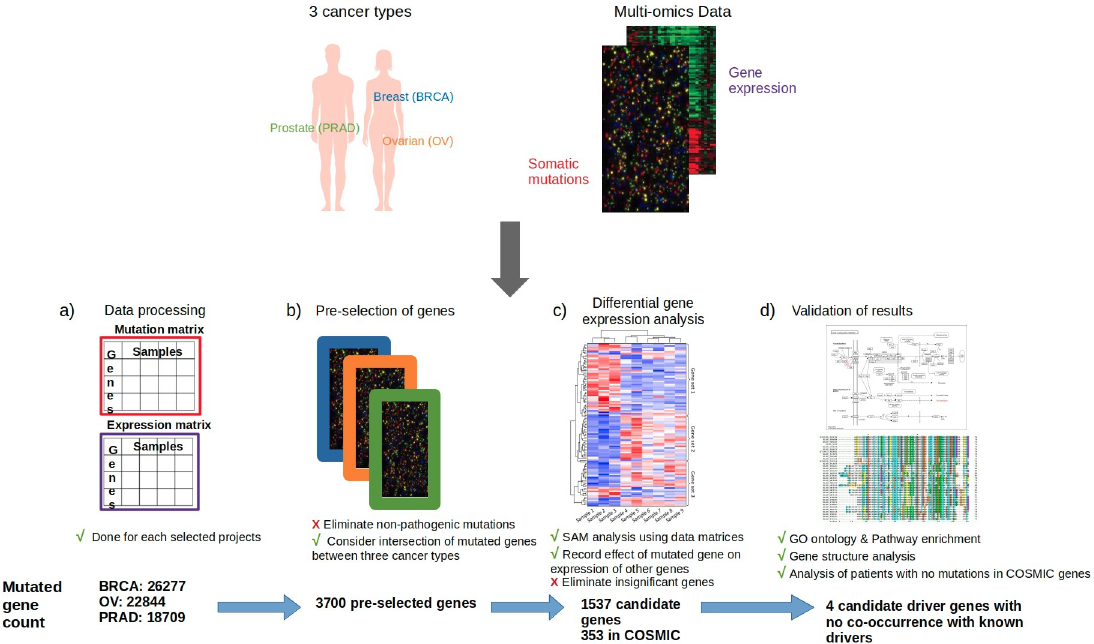
Fig 1. Summary of approach. In this research, we have identified novel driver mutations by computing the intersection of mutational and gene expression data, and later validated candidate driver mutations using literature mining and pathway analysis. This study pooled together mutational and gene expression data from three cancer types (breast, ovarian and prostate cancers) from TCGA datasets to demonstrate an unbiased approach for cancer-driver gene selection. a) Mutation and gene expression data are processed into mutation and expression matrices for integrative data analysis; b) Pre-selection of genes includes the exclusion of non-pathogenic variants, and an intersection of the remaining mutated genes in the three cancer types (TCGA datasets). c) The pre-selected genes are investigated for their effect on gene expression (as a measure of functionality) by performing differential gene expression analysis. d) The final genes are subjected to gene ontology and pathway enrichment for validation, and the same analysis is performed on patients.